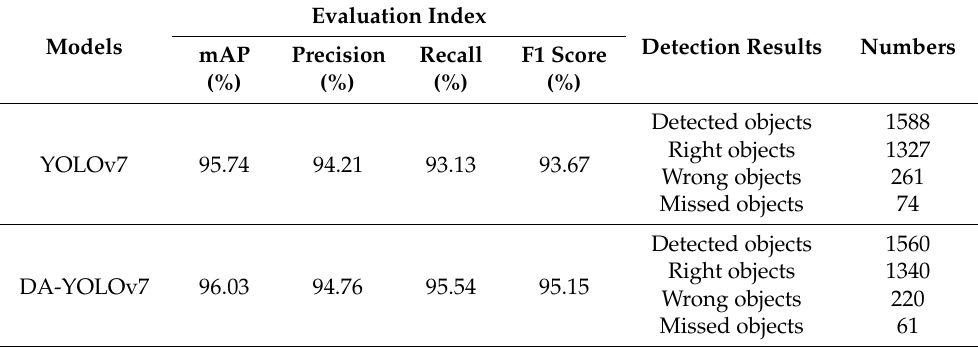
Evaluation Index